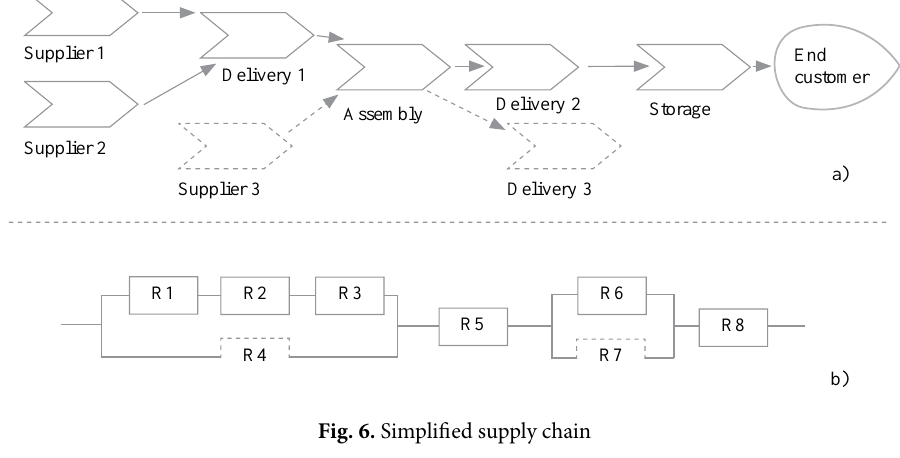
Fig. 6. Simplified supply